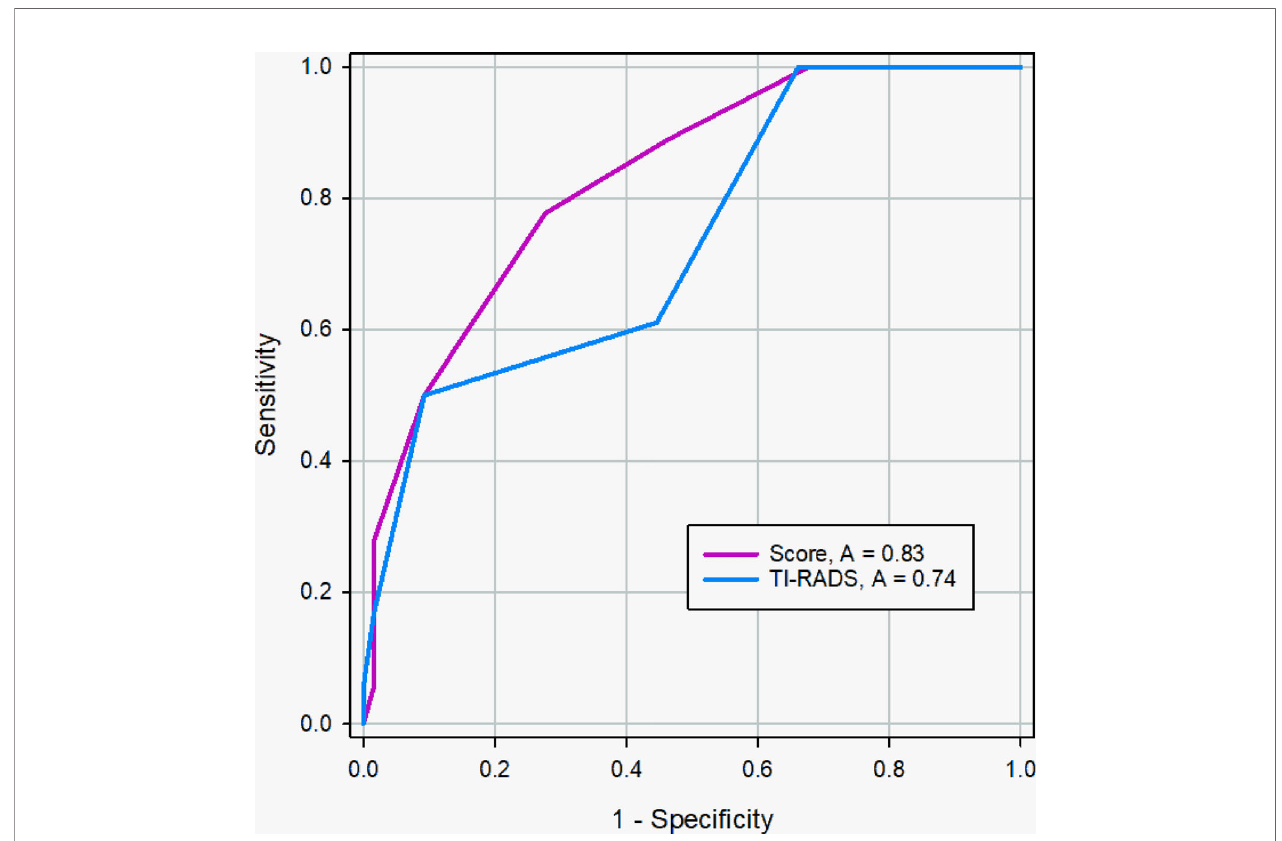
FIGURE 8 | ROC curve of the scoring system and radiologists in the validation cohort. The AUC was signi fi cantly different between two methods (0.83 vs. 0.74), and the DeLong et al. indicated that there was a signi fi cant difference in diagnostic performance between two methods ( p =